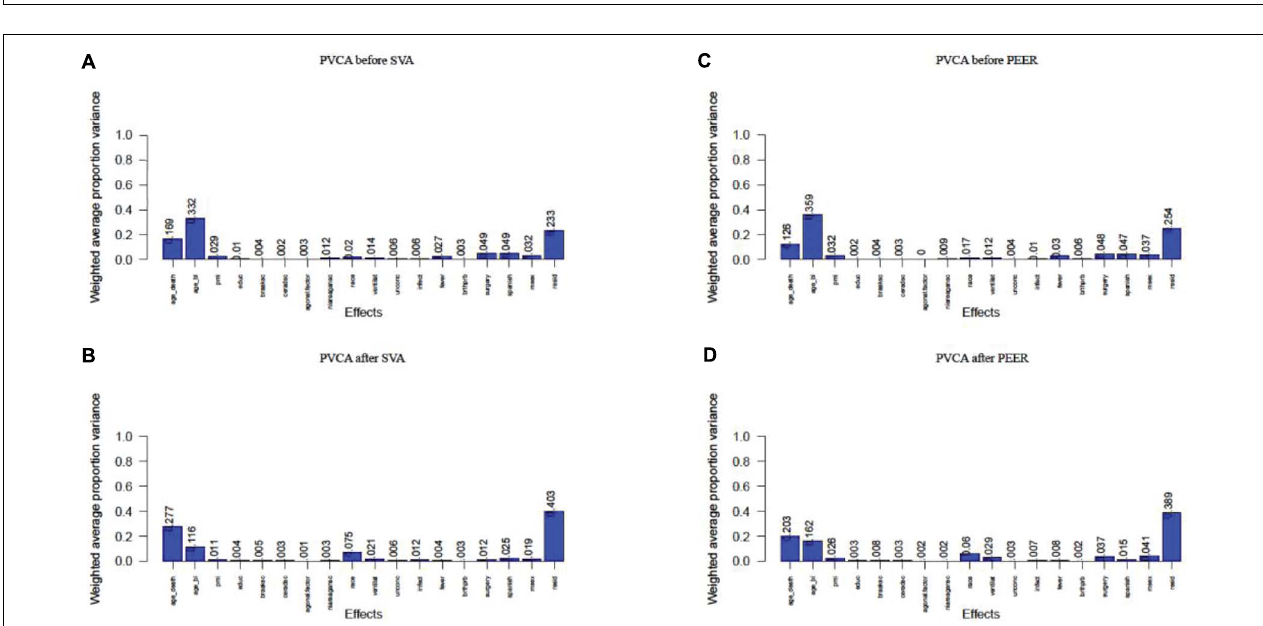
FIGURE 8 | Unknown factors discovered by SVA (A) and PEER (B) and terminal state correlation. (A) Surrogate variables 1, 2, 4, 5, 6, 7, 9, 10, 12, and 14 have a significant correlation with terminal states; (B) Hidden factors 1, 2, 4, 5, 8, 9, 10, 12, 13, and 15 have a significant correlation with terminal states.